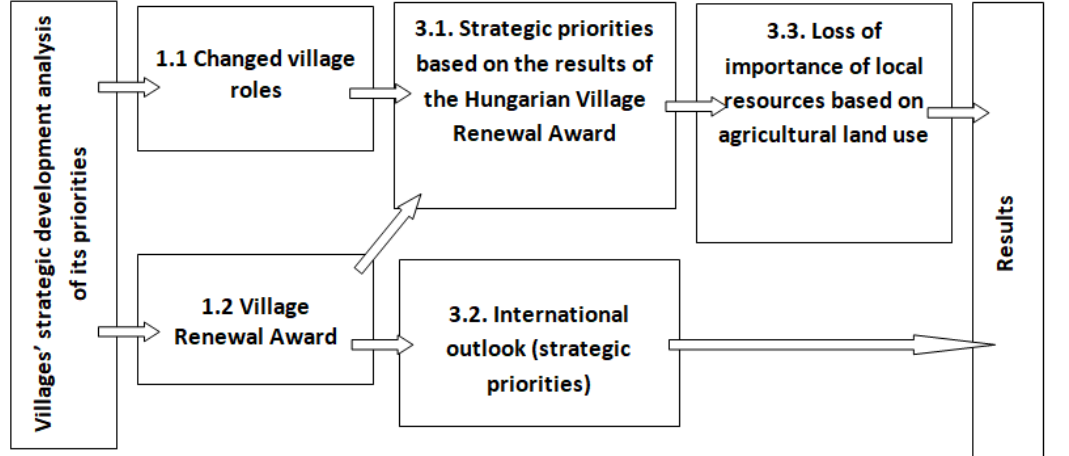
Figure 1. The logical connection of the researched topics.